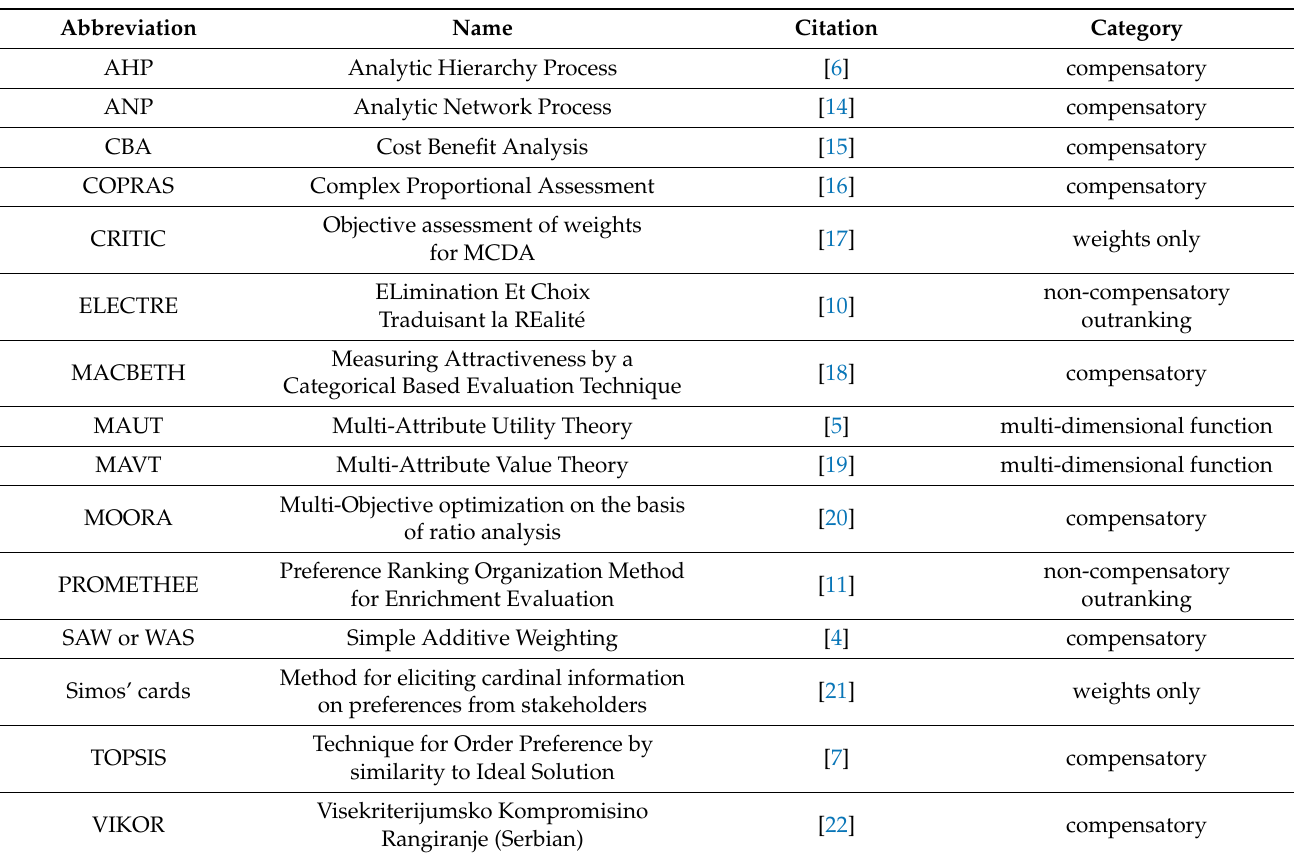
Table 1. Key methods discussed in this paper (with